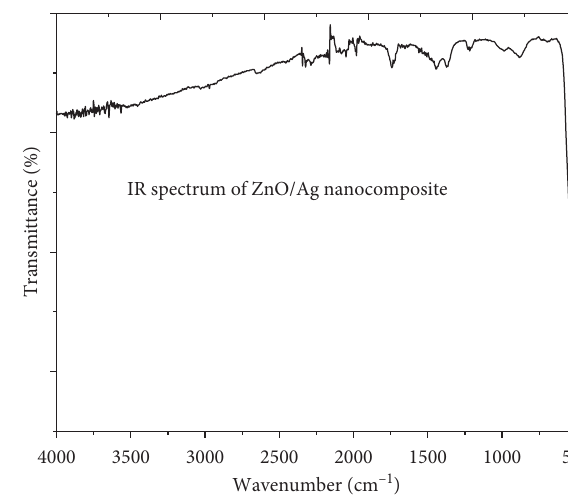
Figure 9: FTIR spectra analysis of CuO/Ag nanocomposite. Figure